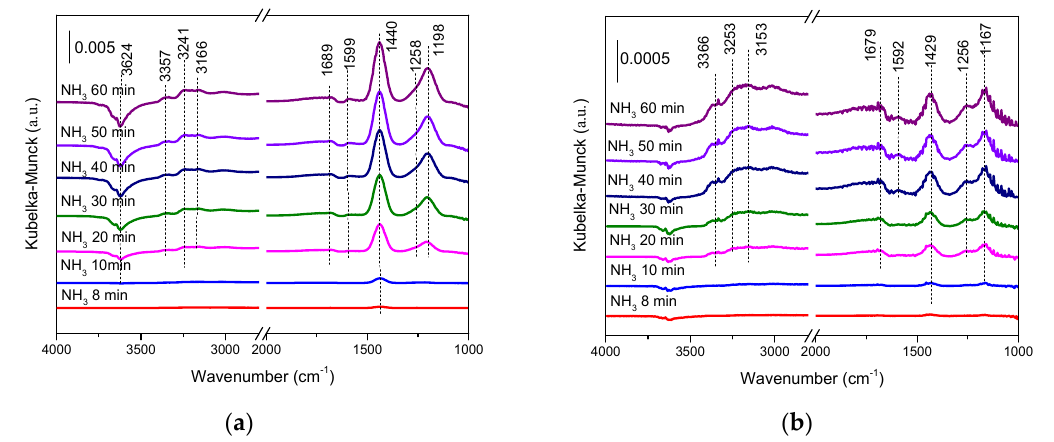
Figure 8. The in situ diffuse reflectance infrared Fourier transform (DRIFT) of NH 3 adsorption over ( a )the SbCeZr and ( b ) the SbCe catalysts at 200 °C. NH 4+ -B species (1440 cm −1 ) appeared after exposing in NH 3 for 8 min over SbCeZr as shown in